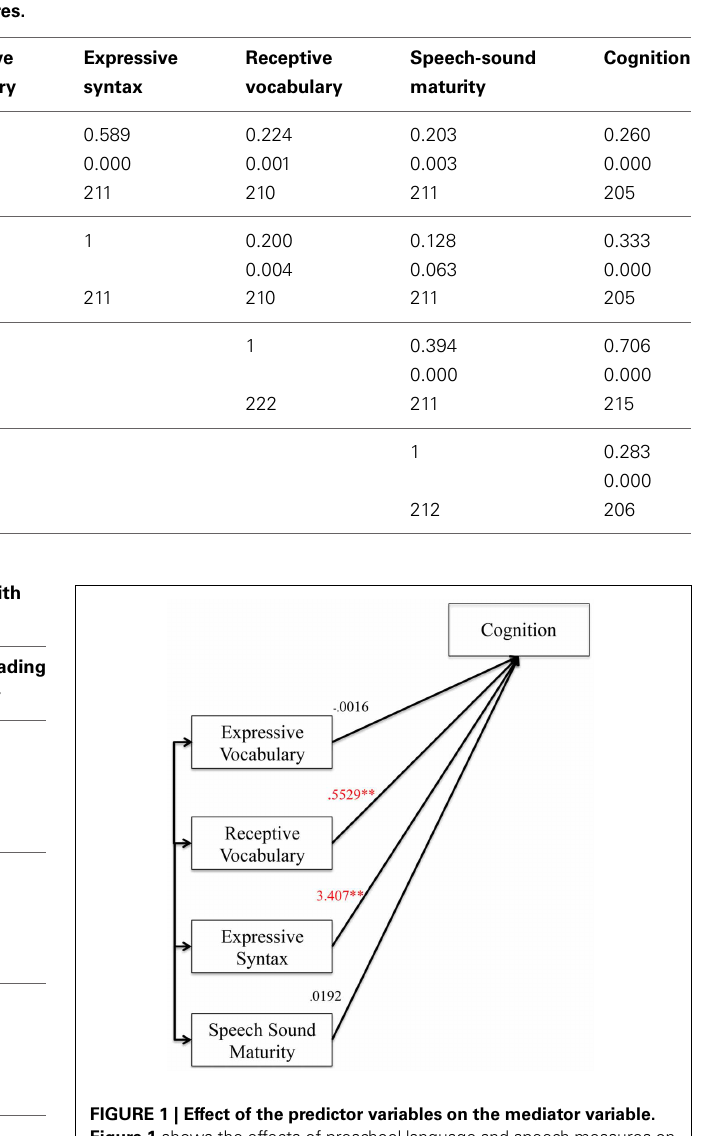
Table 3 | Pearson moment correlations among preschool measures.